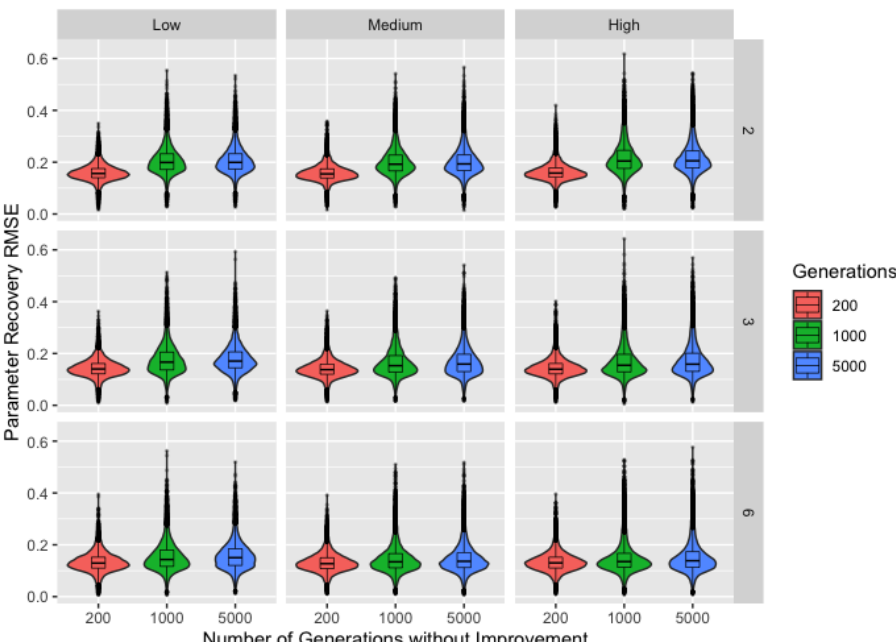
Figure 4. Boxplots and violin plots for root-mean-square-error for recovery by number of generations without improvement with ProbSigma hyperparameter levels (horizontal) and number of time steps (vertical) across